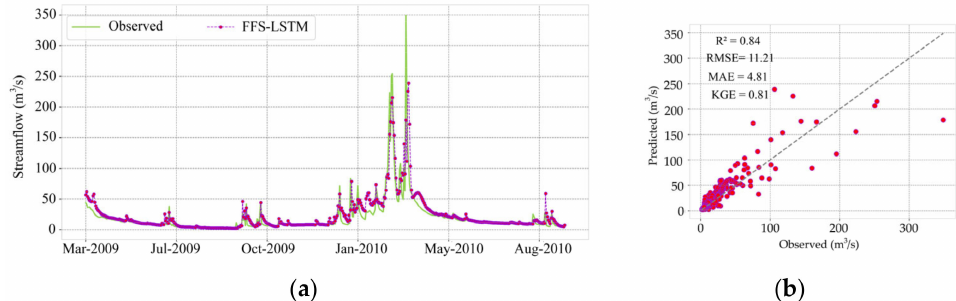
Figure 9. The hydrograph of observed and predicted daily streamflow of FFS-LSTM scenario during the testing ( a ) using approach 2 at TS = 20 with the corresponding scatter plot ( b